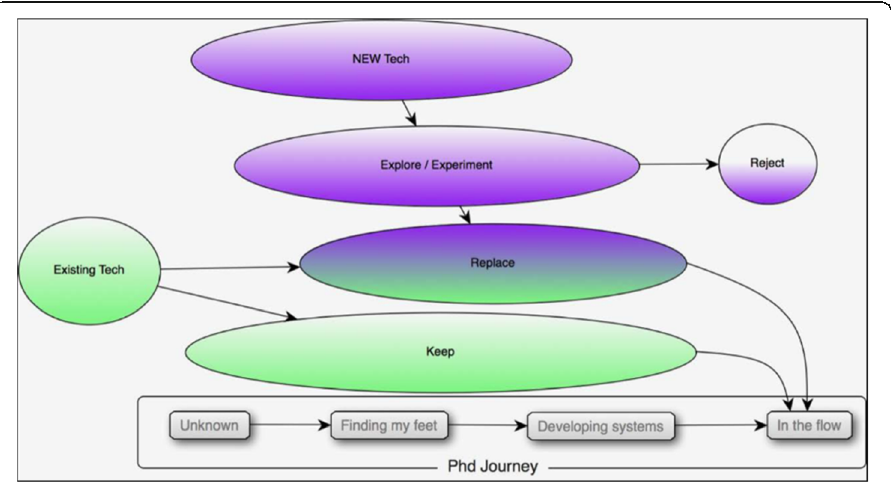
Fig. 2 ICT and individuals work alongside each